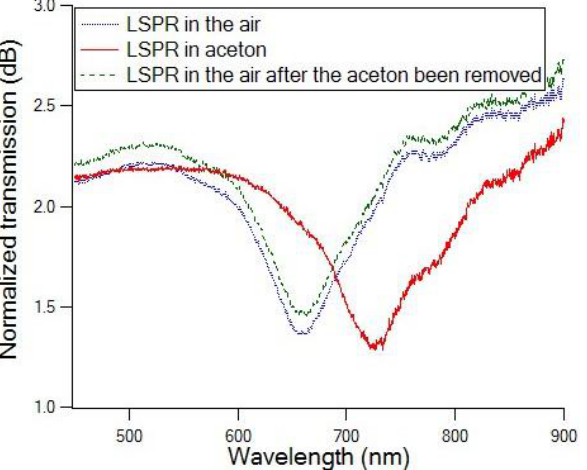
Figure 4. The transmission spectra of the fabricated fiber sensor in the air (blue dot and green dash) and in acetone (red